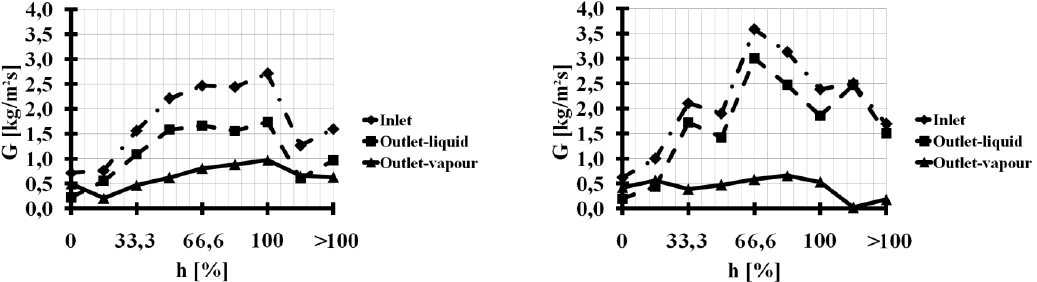
Figure 4. The mass flux of the test fluid at the inlet to the evaporator and at the separator outlets as a percentage function of the filling height: Left —minigap 2 mm; right —minigap 3 mm.